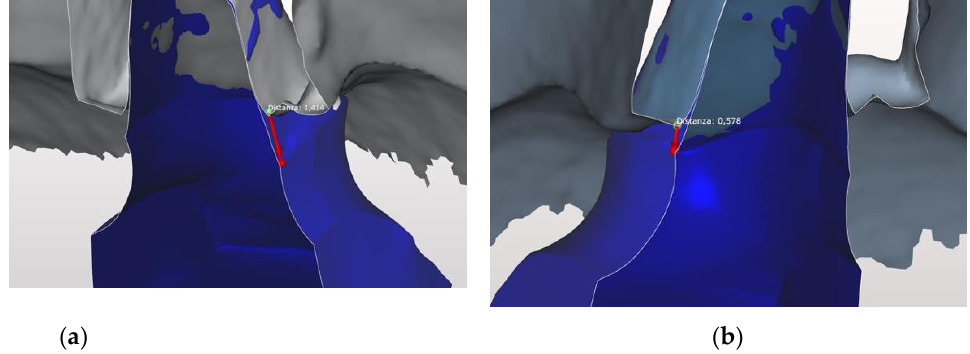
Figure 5. Differences in preparation reading of the two impressions in the mesial and distal areas ( a , b ).